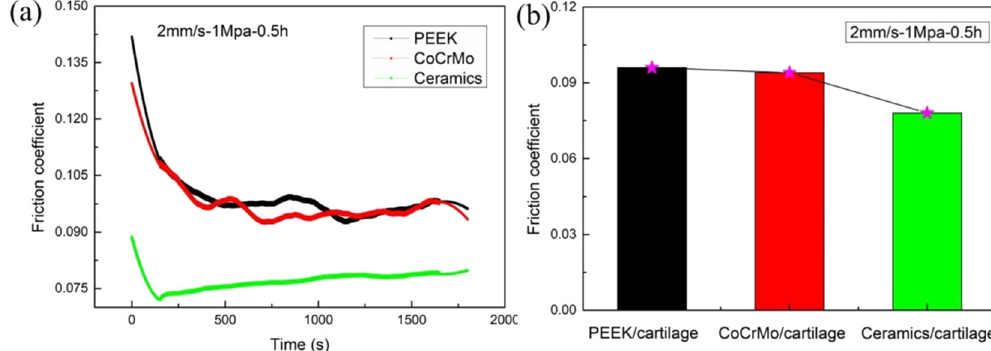
Fig. 6 The friction coef fi cient of different friction pairs. a Time-varying friction coef fi cient; b stable friction coef fi cient